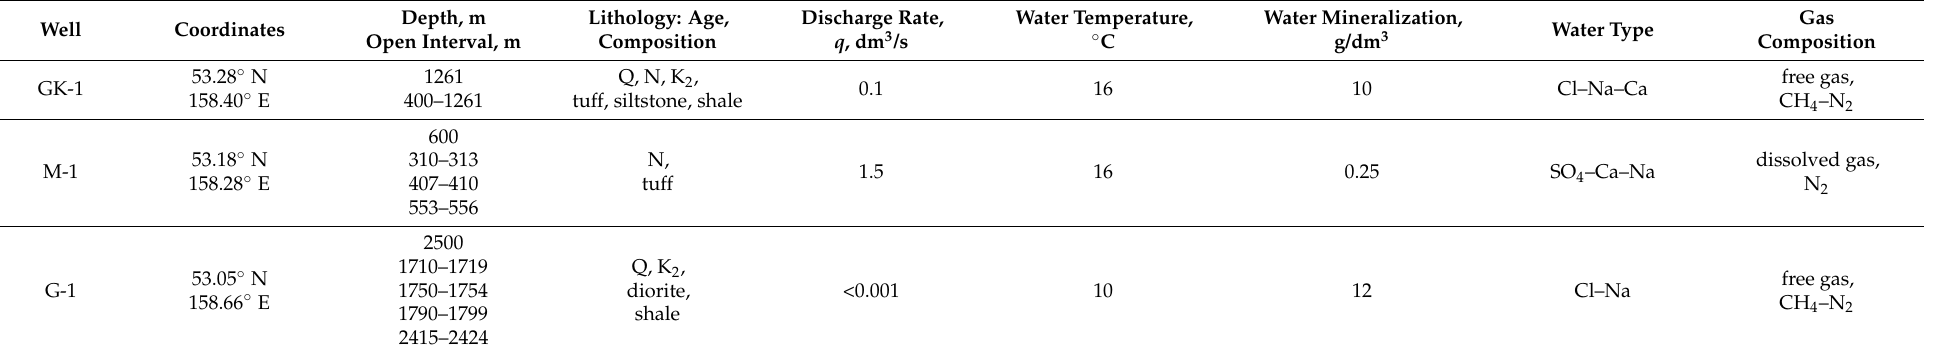
Table 1. Observation wells, Kamchatka Peninsula.